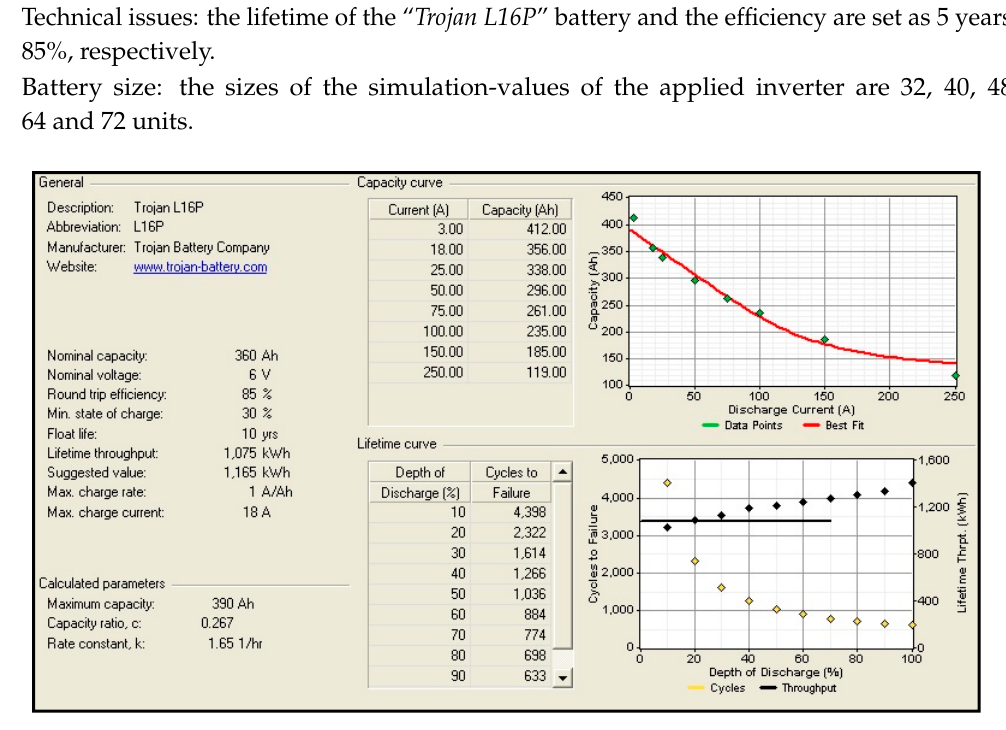
Figure 12. “ Trojan L16P ” battery model characteristics.